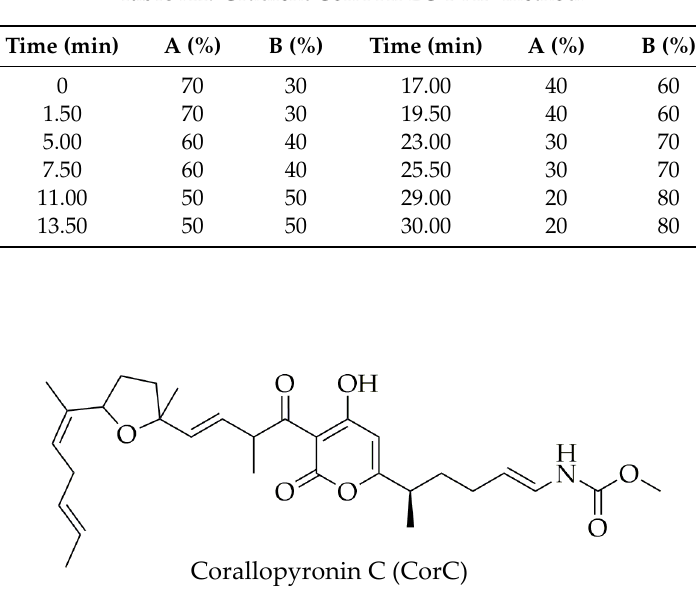
Table A1. Gradient CorA HPLC-DAD method.